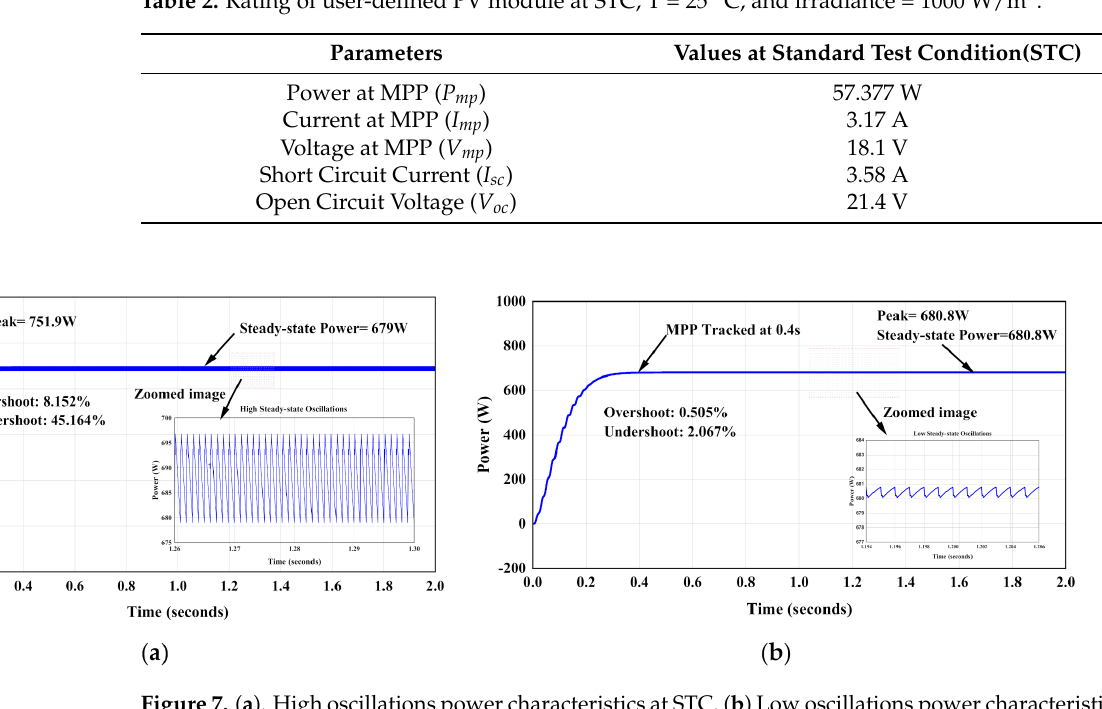
Figure 7. ( a ). High oscillations power characteristics at STC. ( b ) Low oscillations power characteristics at STC.